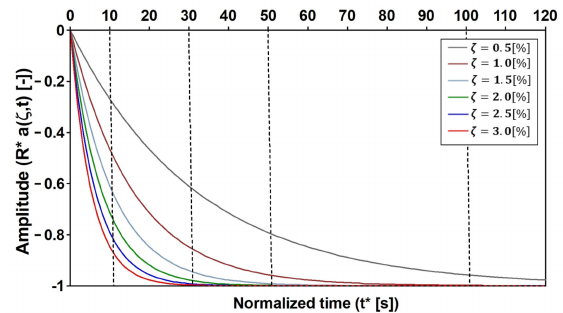
Figure 12. The SDOF when subjected to a harmonically varying load force, specifically, the natural conditions. The transient term, at resonance, vs. the normalized time and the critical damping.